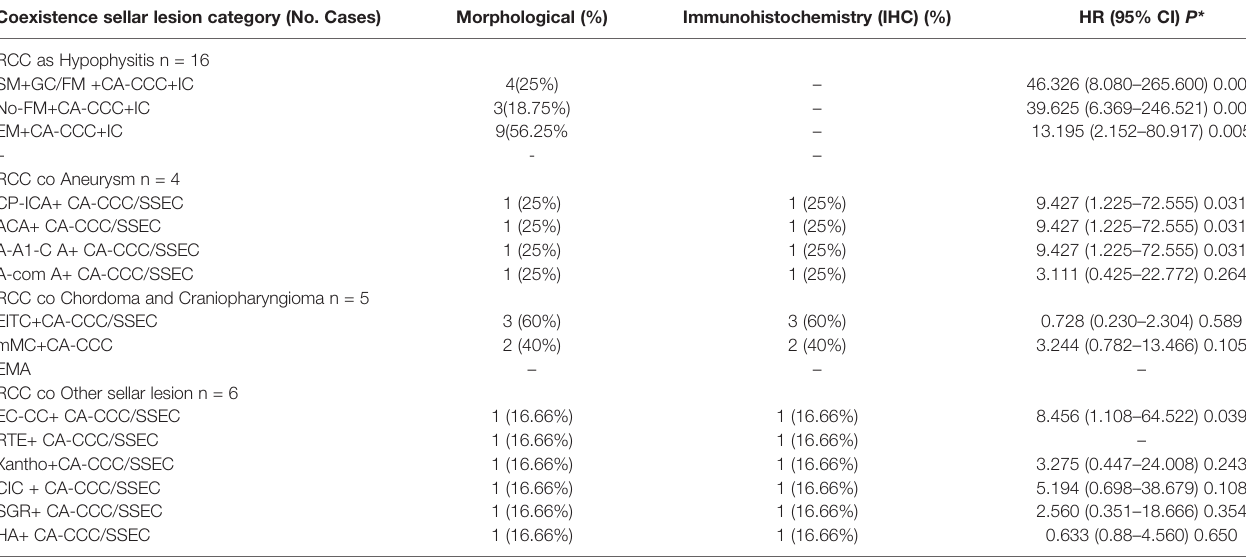
TABLE 3 | RCC coexistent various type other sellar lesion and histopathological features and immunohistochemistry. Coexistence sellar lesion category (No.